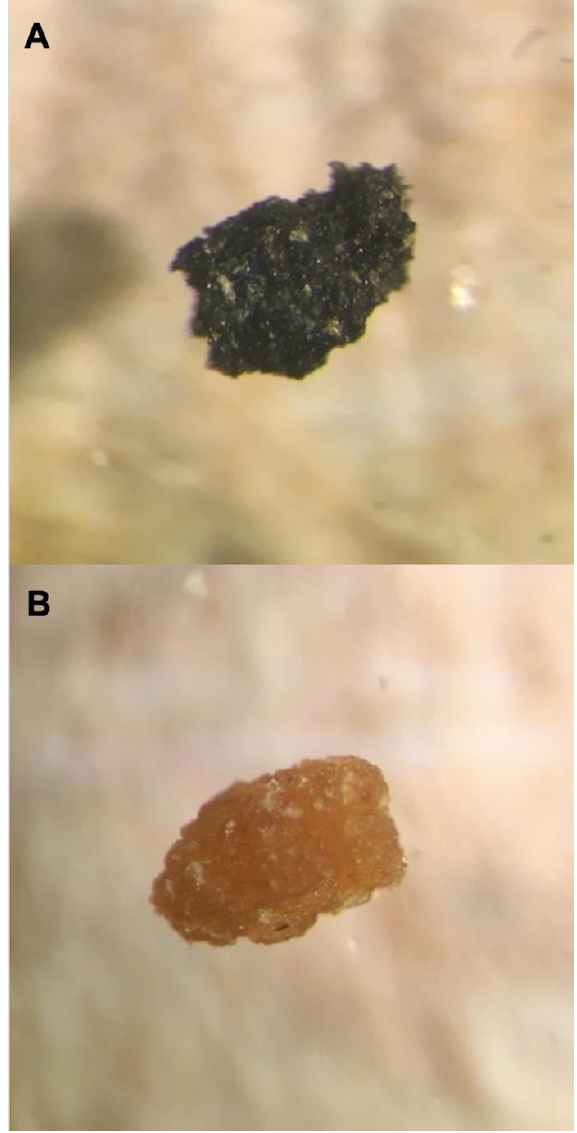
Figure 6. Orgyia pseudotsugata frass viewed at 40× magnification, collected from larvae reared on synthetic diet in ( A ) the 10% biochar treatment and ( B ) the control 0% biochar treatment.